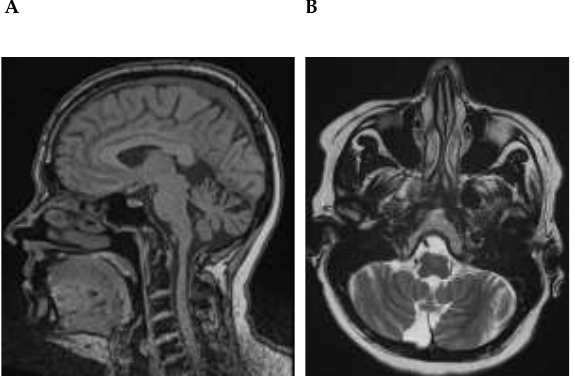
Figure 2: Cerebellar atrophy in a patient associated